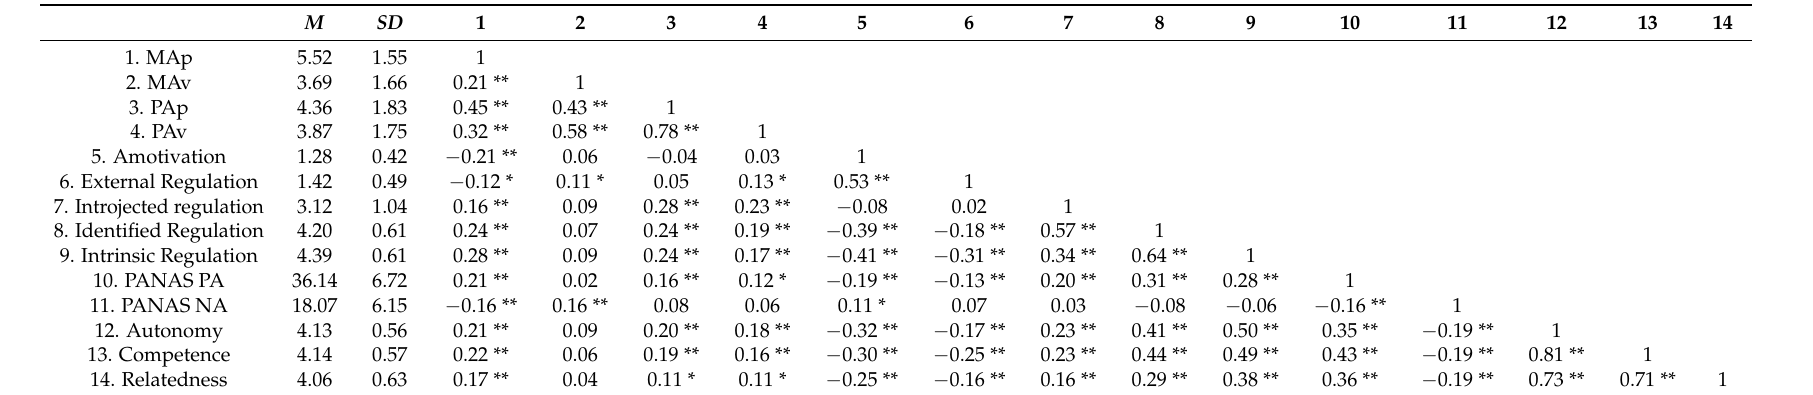
Table 1. Descriptive statistics and correlations between all variables of the overall